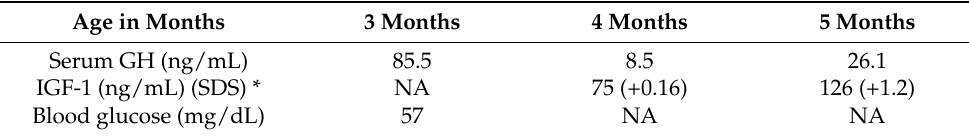
Table 1. Pre-feeding serum GH levels and IGF-1